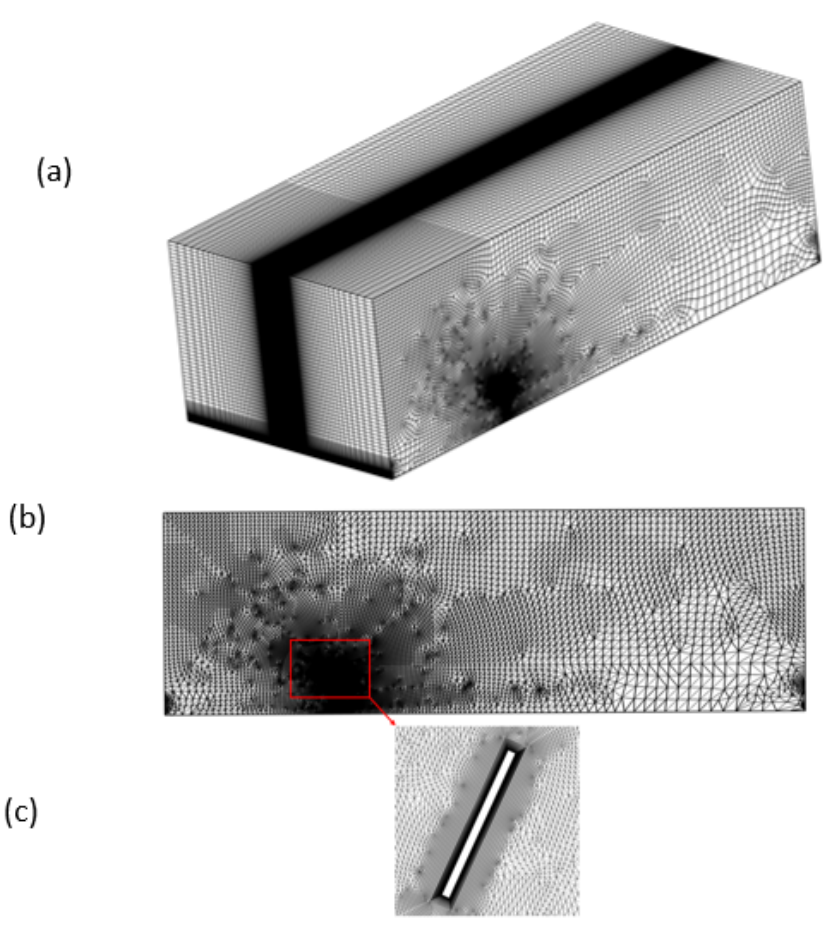
Figure 7. Computational mesh used in the present simulations: ( a ) isometric view; ( b ) vertical plane across the centre of the PV panel; ( c ) close to the PV panel.